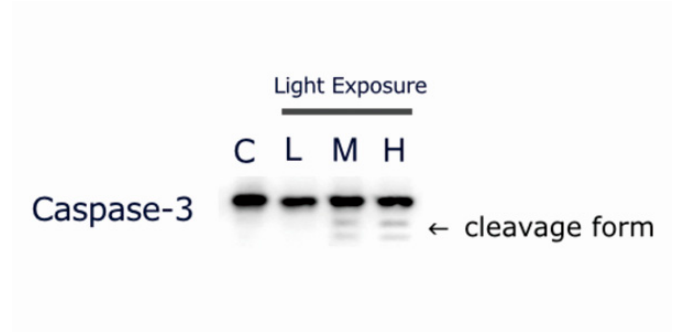
Figure 7. Exposure to liquid crystal display (LCD) with medium and high ocular energy exposure index (OEEI) increases cleaved caspase-3 expression in 661W cells. 661W cells were exposed to LCD with low, medium, and high OEEI for 3 days. The caspase-3 expression levels were analyzed by western blot. In medium and high OEEI groups, the cleavage forms of caspse-3 were